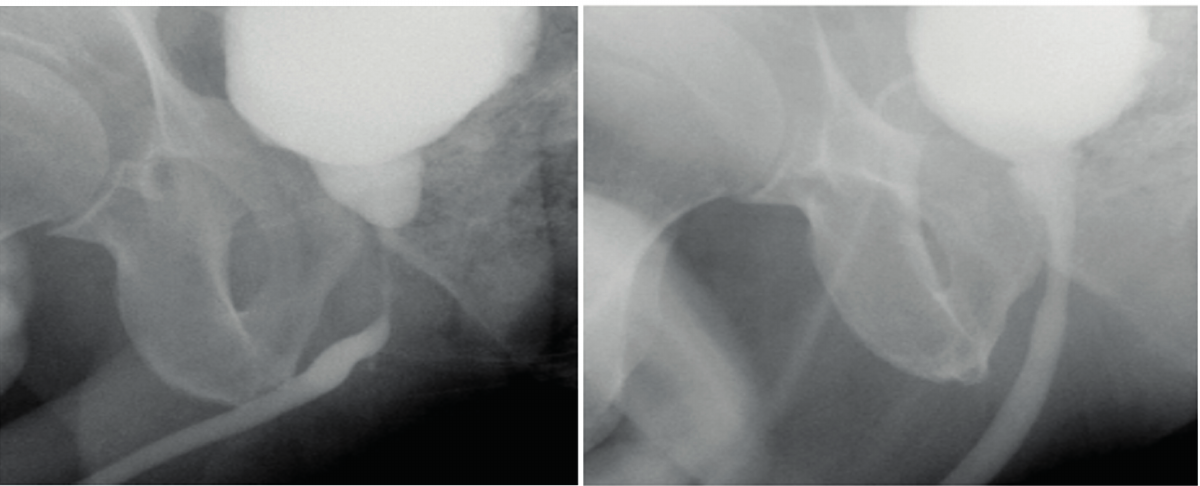
Figure 2 - Pre and post ORA cystourethrography in perineal approach.